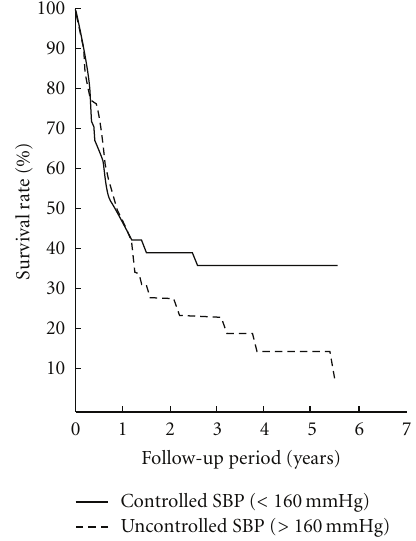
Figure 4: Survival rates in medically treated patients with malig- nant hypertension according to blood pressure control (modified from Harington et al.